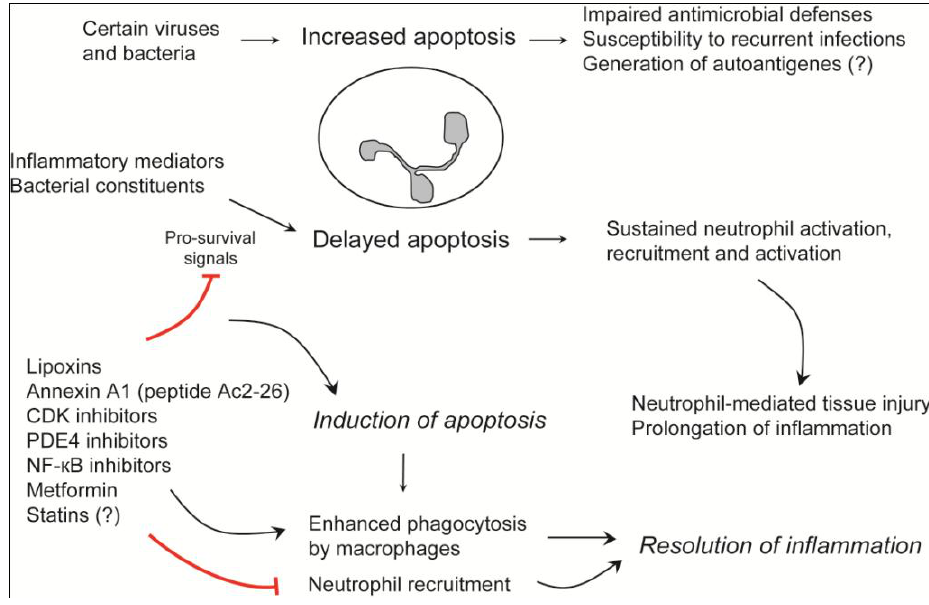
FIGURE 1. Neutrophil apoptosis influences the outcome of inflammation. Accelerated neutrophil apoptosis by certain viruses or bacteria increases susceptibility to severe recurrent infections and may contribute to generation of autoantigens. By contrast, suppression of constitutive neutrophil apoptosis by proinflammatory mediators or bacterial constituents leads to aggravated tissue injury and prolongation of the inflammatory response. Inhibition of neutrophil recruitment and redirecting neutrophils to apoptosis promote clearance of inflammatory cells and ultimately enhances the resolution of